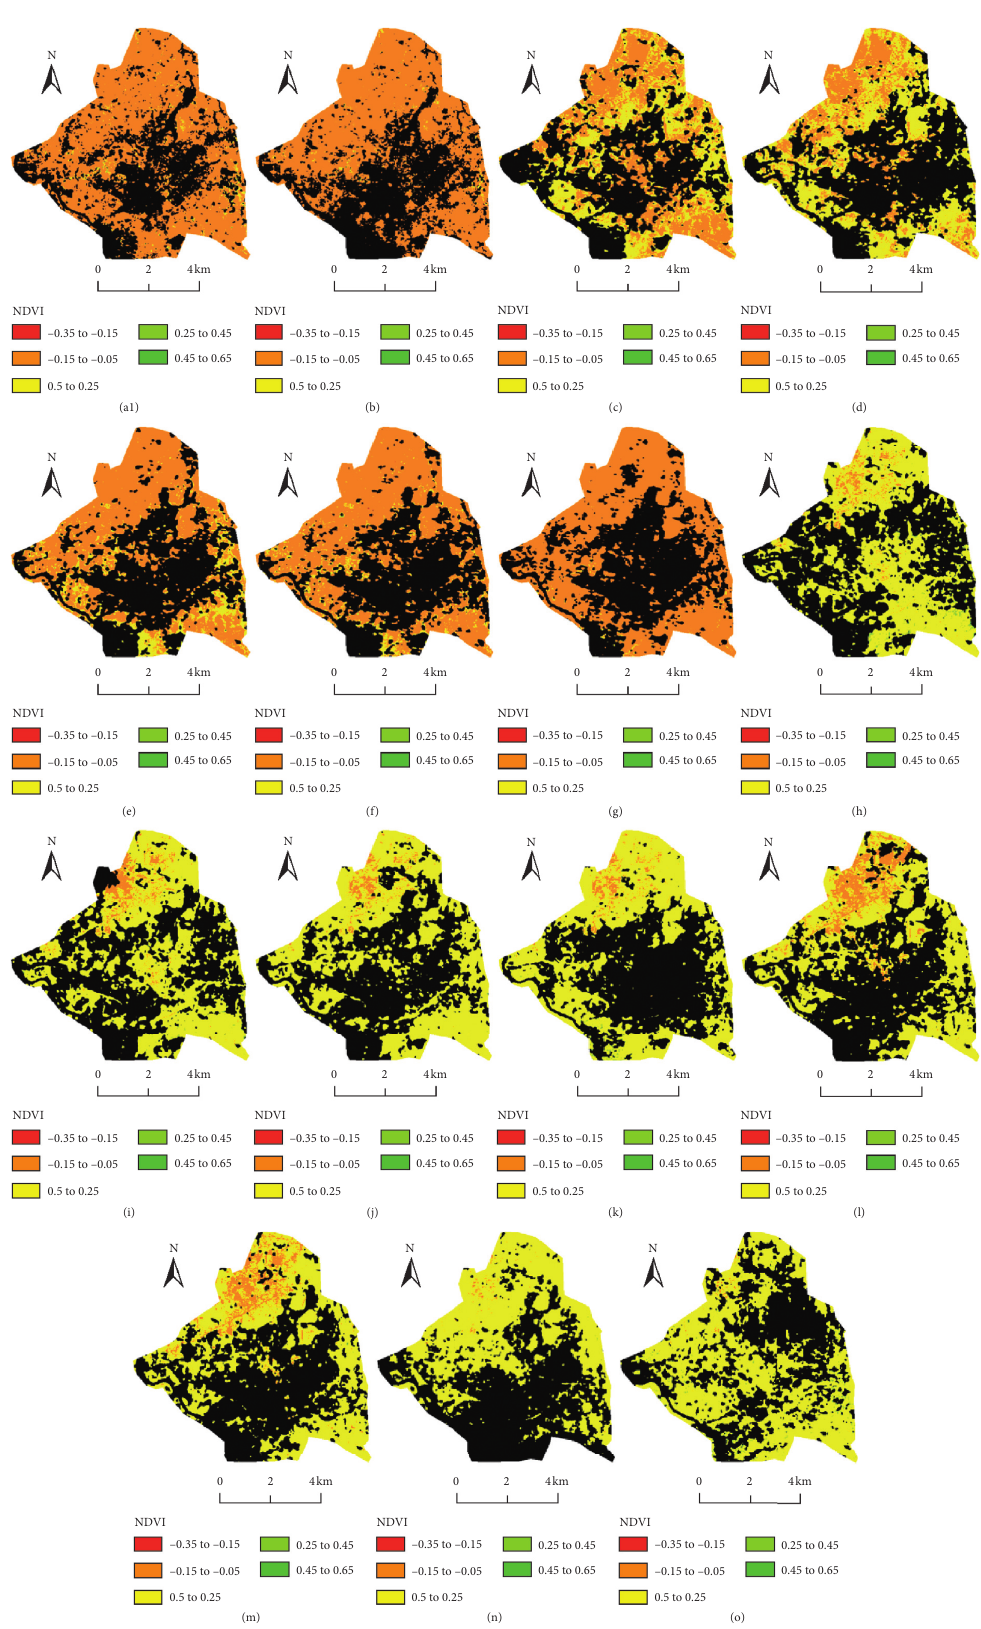
Figure 7: NDVI in the area above mean LST: (a-b) 2002, (c-d) 2006, (e–g) 2010, (h–k) 2014, and (l–o) 2018. The black portion of the maps shows the area below mean